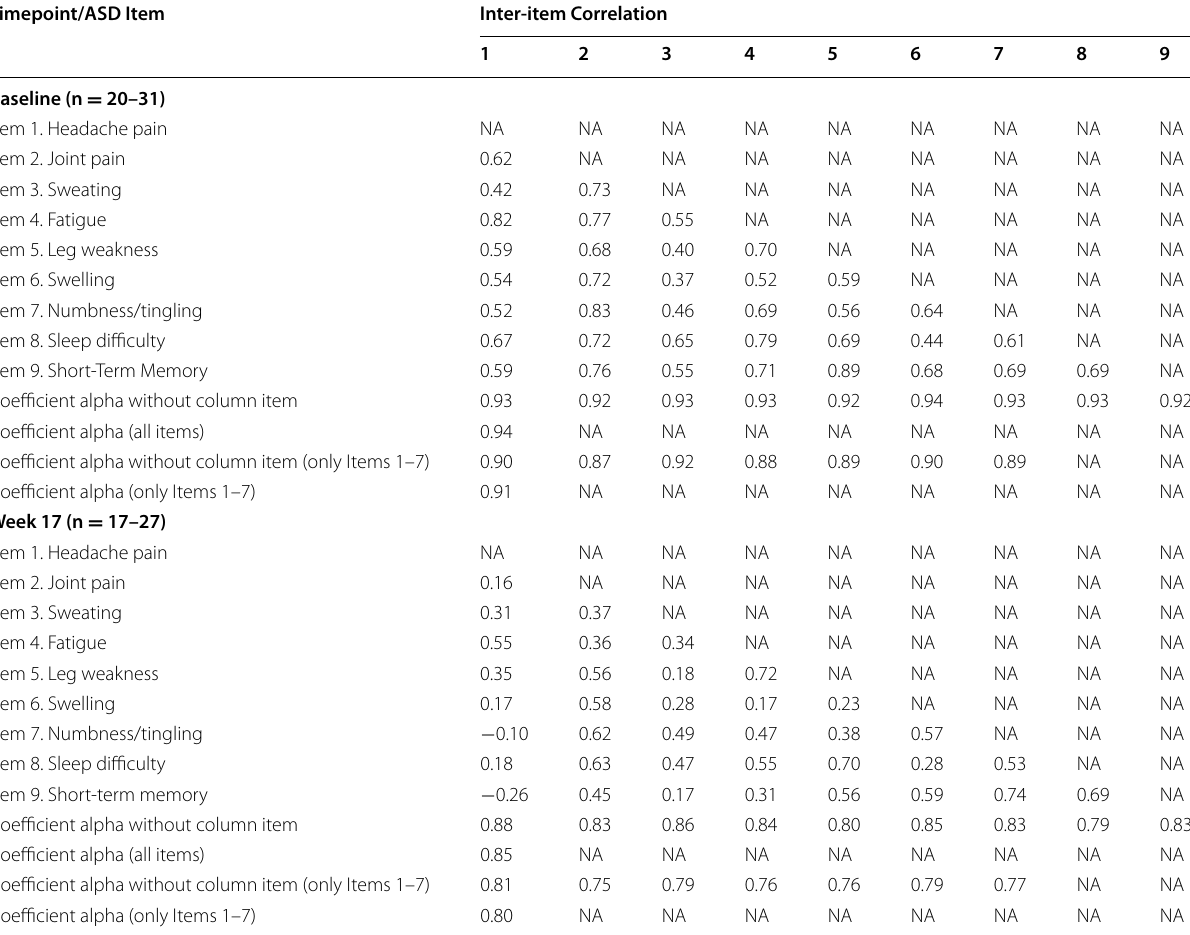
ASD Acromegaly Symptoms Diary; NA =